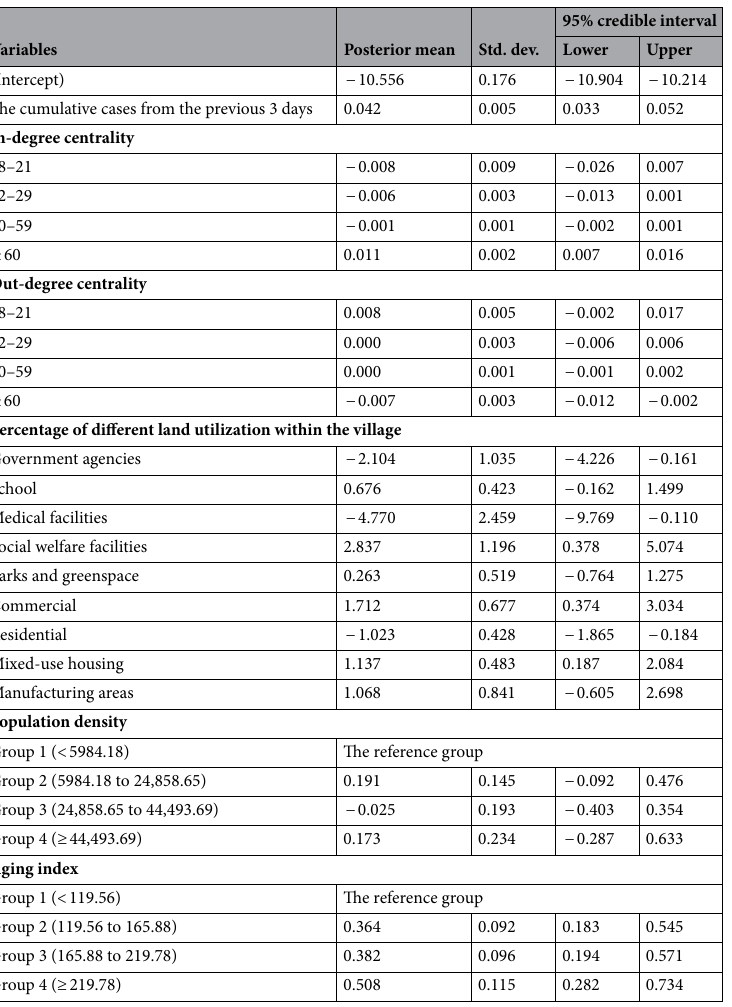
Table 2. The effects of mobility structure changes and types of land utilization on daily COVID-19 cases at the village